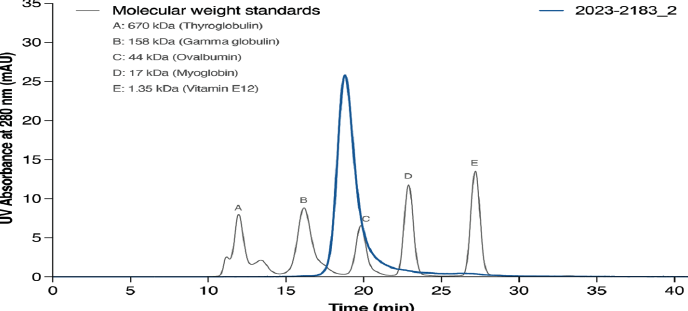
Figure 1. Activation, purification, identification of recombinant ecarin (rEcarin). ( A ) TEV activation of rEcarin analyzed by polyacrylamide gel electrophoresis (SDS-PAGE) staining (Left hand panel) and Western blotting assay by an anti-FLAG-HRP conjugate antibody (Origene) (Right hand panel). 1. Tobacco etch virus protease (TEV) only, Arrows showing TEV in Lane 1 and 3. 2. Full length of rEcarin. 3. Full length of rEcarin with TEV activation. 4. Full length of rEcarin with Aminophenyl mercuric acetate (APMA) activation; 2 µ g of TEV only was loaded in Lane 1; 10 µ g of unpurified rEcarin were loaded in Lane 2, and 4; 10 µ g of unpurified rEcarin containing 2 µ g of TEV were loaded in Lane 3. ( B ) CM-Chromatography of rEcarin. Combined fractions from the CHA column in low salt buffer were applied manually to a 20 mL column of CM-Sepharose, washed through with the same buffer, and eluted stepwise in 10 mL fractions with 0.5 M NaCl in the same buffer. rEcarin containing fractions were pooled (shaded), concentrated and buffer exchanged into 25 mM Hepes pH 7.4, 0.01% Tween 20. ( C ) Identification of purified rEcarin (1224-P9) by SDS-PAGE and Western blotting assay; 0.5, 1 and 2 µ g of the purified rEcarin were loaded for each lane for SDS-PAGE staining (Left hand panel) and Western blotting assay (Right hand panel). ( D ) Comparison of N–Ecarin with rEcarin by SDS-PAGE and Western blotting assay; 2 µ g of both N–Ecarin and purified rEcarin were loaded on one gel lane for SDS-PAGE staining (Left hand panel) and Western blotting (Right hand panel). An inhouse produced anti-ecarin polyclonal antibody, prepared in a rabbit, was employed for the Western blotting. ( E ). A representative SEC of the purified